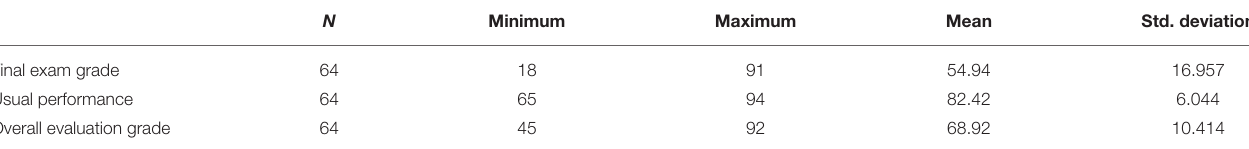
TABLE 2 | Descriptive statistics of an online-offline teaching model.